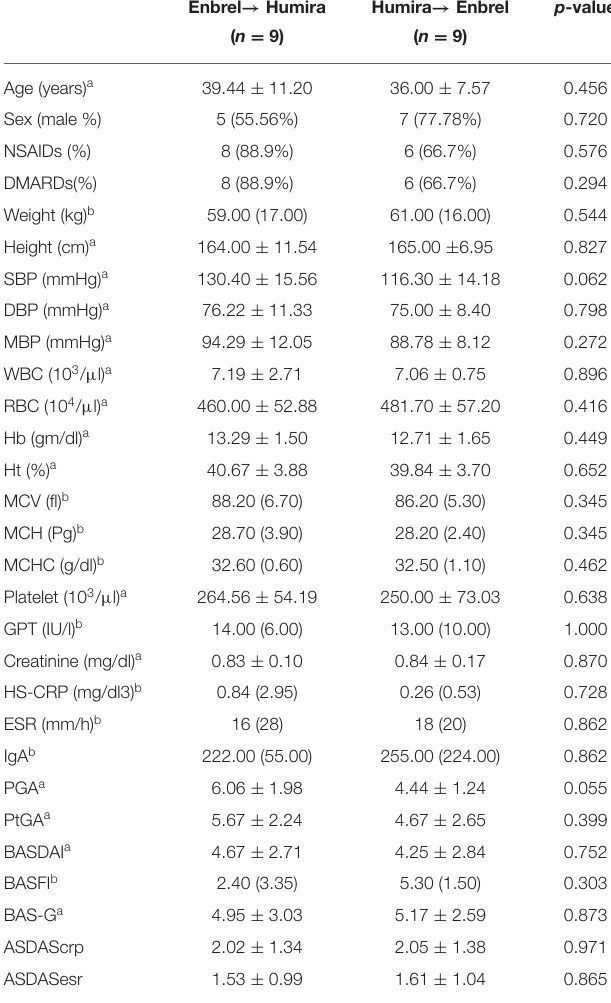
TABLE 1 | Baseline demographics